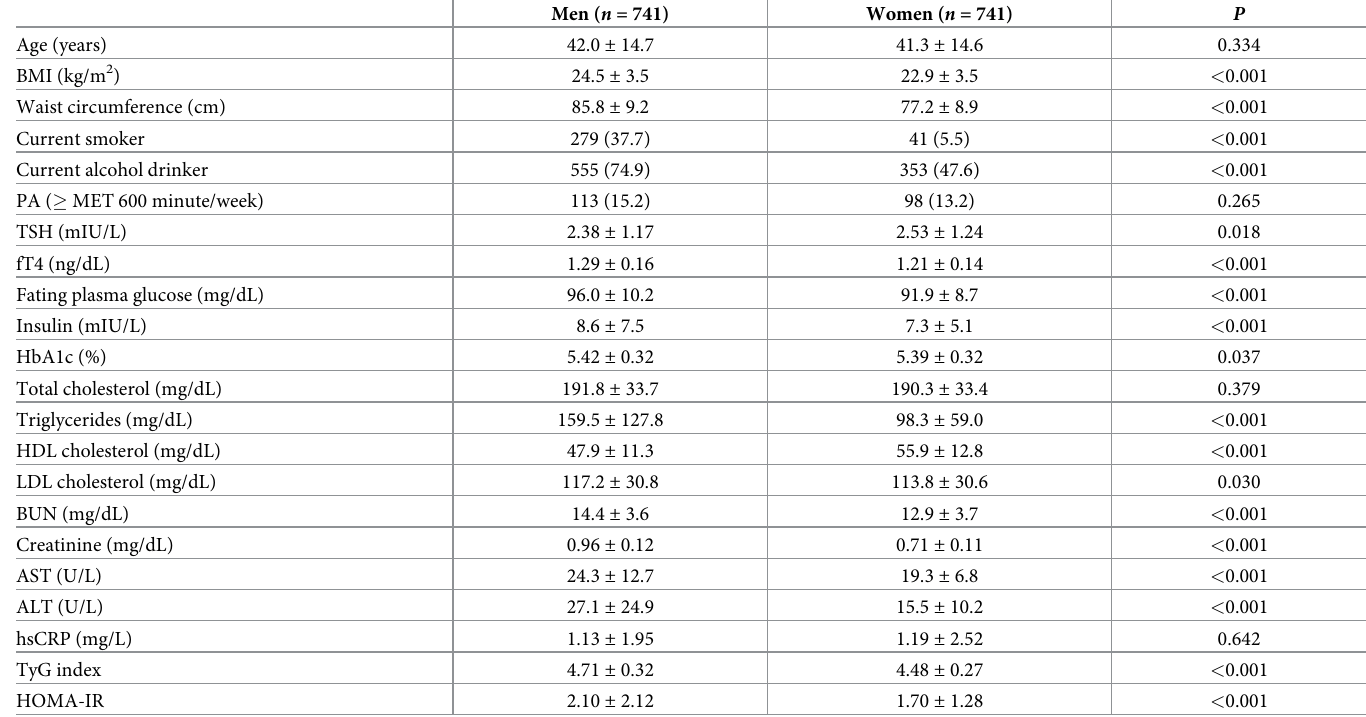
Table 1. Baseline characteristics of the study